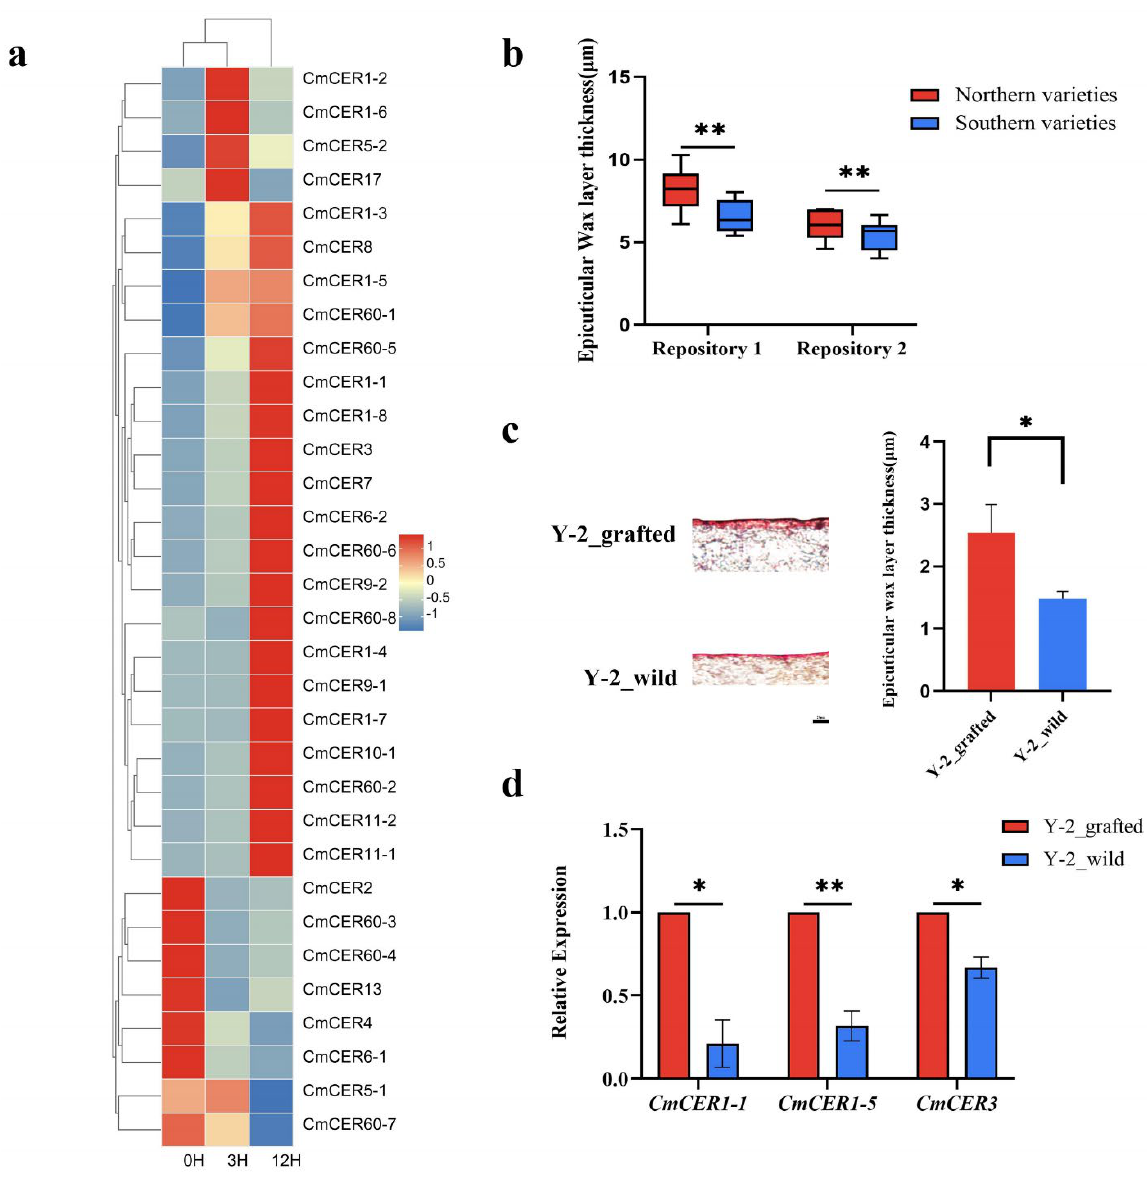
Figure 7. ( a ) Expression levels of CmCER genes in drought-treated Chinese chestnut seedlings. ( b ) Comparison of differences in leaf epicuticular wax layer thickness between northern and southern varieties in the Beijing and Liyang germplasm repositories. Repository 1: Chestnut Experiment Station in the Huairou District of Beijing, China. Repository 2: Liyang Longtan Linchang. Error bars indicate standard errors. ‘**’ on the error bar indicates a significant difference between the two groups at p < 0.01. ( c ) Results of semi-thin sections of wild Y-2 leaves in Hubei and grafted Y-2 leaves in the north. Error bars indicate standard errors. ‘*’ on the error bar indicates a significant difference between the two groups at p < 0.05. The length of the scale is 20 µ m. The complete semi-thin section is shown in Figure S2. ( d ) Expression of CmCER1 - 1 , CmCER1-5 and CmCER3 in grafted Y-2 varieties in the north and wild Y-2 varieties in the south. Error bars indicate standard errors. ‘*’ or ‘**’ on the error bar indicates a significant difference between the two groups at p < 0.05 or p < 0.01,